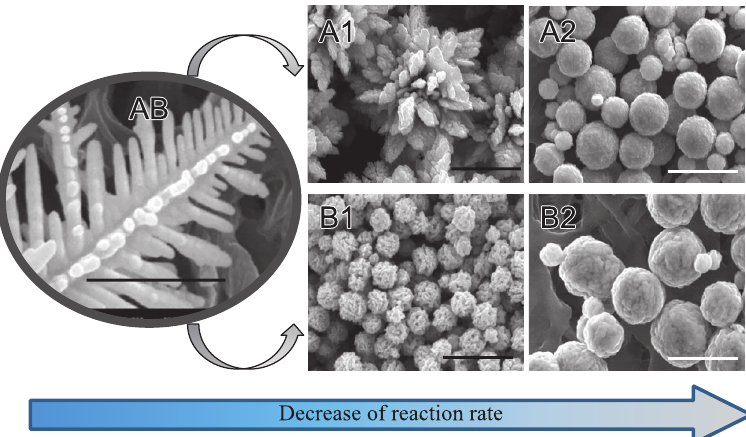
Fig. 8 SEM images of the silver products synthesized in arginine ( A ) and phenylalanine ( B ) solution at various concentrations, and the reaction time was fixed at 30 minutes. AB showing the silver dendrites synthe- sized without any amino acids; A1 and A2 showing the silver particles synthesized in the arginine solu- tion of 5 mM, 20 mM, respectively; B1 and B2 showing silver particles synthesized in phenylalanine solution of 0.5 mM, 5 mM, respectively. The scale bars represent 1